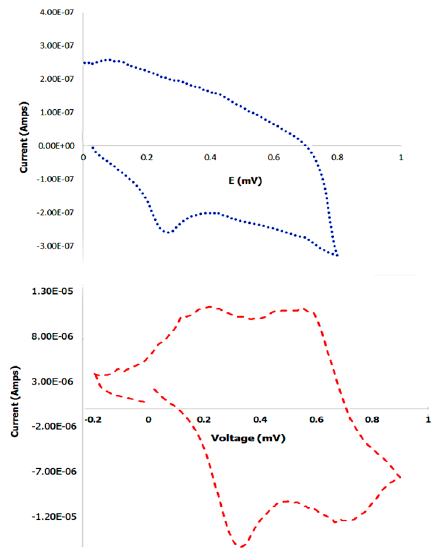
Figure 12. Comparison of cyclic voltagrams of control PANI (top) and PANI bound scaffold (bottom).